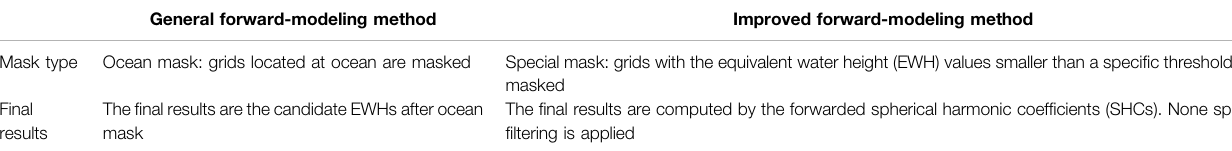
TABLE 2 | Comparison of general forward-modeling method and improved forward-modeling method.